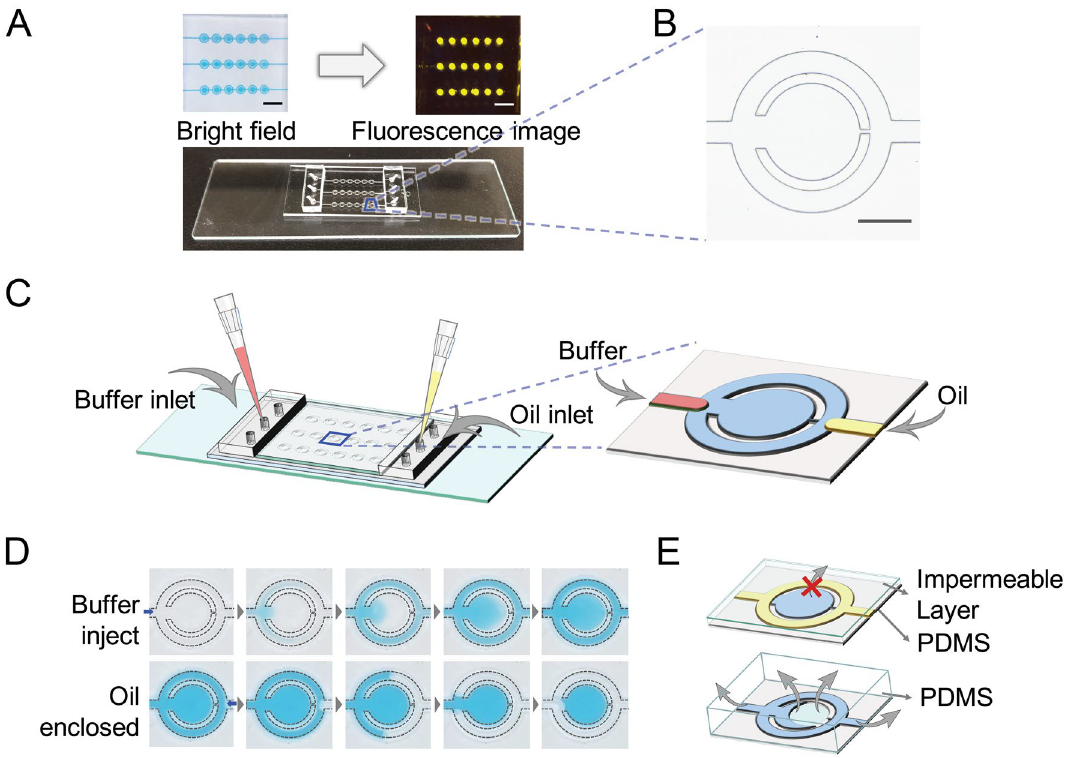
Figure 1. Schematic illustration of the passive-driven MF-LAMP chip. ( A ) Photograph of the MF-LAMP chip with blue dye (bright field) and fluorescence dye (fluorescence image) to indicate the microfluidic network. Scale bars are 3 mm, ( B ) Bright field image of a single chamber. Scale bars are 0.5 mm. ( C ) Simple operation of bidirectional fluid regulation by using micropipettes integrated into the MF-LAMP device. Illustration of mechanism is visualized by PowerPoint. ( D ) The process of buffer exchanging and oil enclosed method through capillary channel. ( E ) Principle of the oil enclosed and impermeable layer that prevents LAMP reagent loss by liquid/gas diffusion through the inlet and PDMS. Illustration of mechanism is visualized by